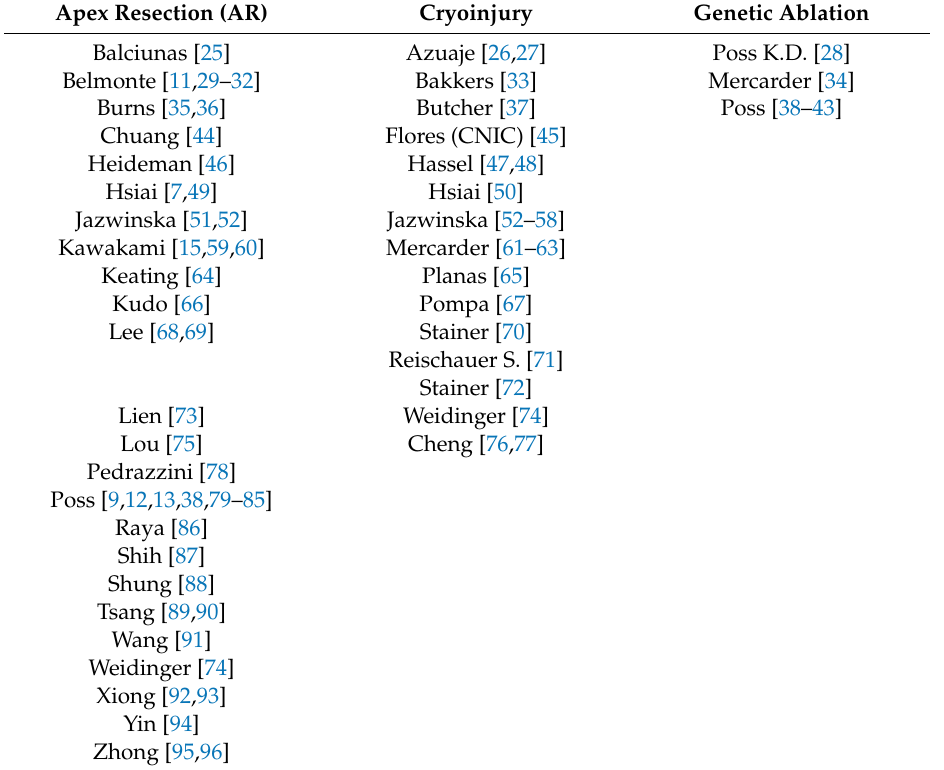
Table 1. Systematically identified zebrafish studies divided by heart injury